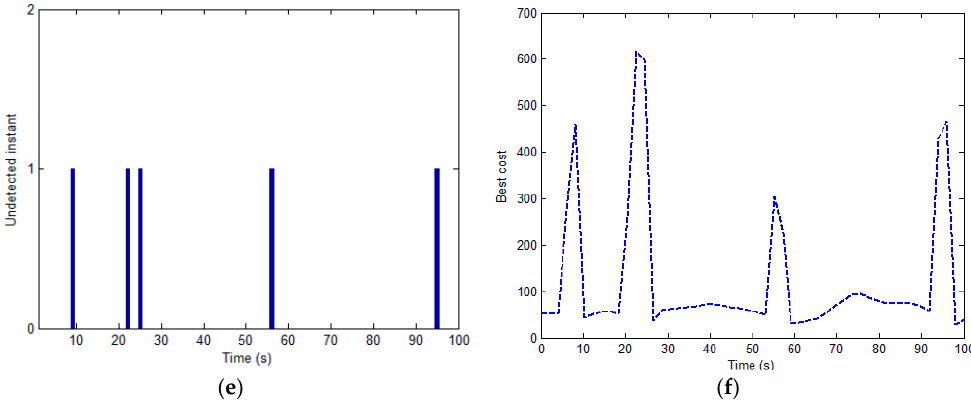
Figure 6. The performance of the proposed method for scenario 1. ( a ) 3D view of the planned path for each UAV; ( b ) Top view of the resulting paths; ( c ) The relative distance among each UAV during tracking; ( d ) The roll-command for each UAV ( e ) The undetected time-instant; ( f ) The total cost of the tracking process.